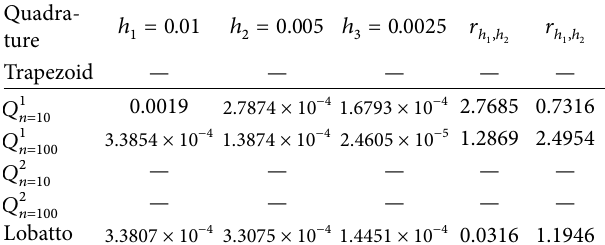
, with the mesh obtained by 𝑎(𝑥) ℎ = Table 4: Relative error for different meshes. Example 3.